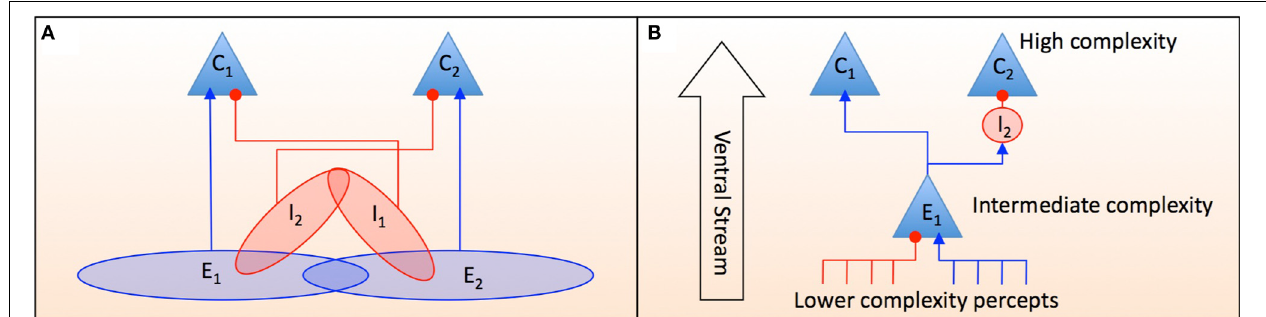
and inhibition. For example the cells in the group E 1 I 2 = E 1 ∩ I 2 excite C 1 and inhibit C 2 whereas the cells in group I 1 I 2 = I 1 ∩ I 2 inhibit both C 1 and C 2 . (B) A more detailed model showing how a neuron in assembly E 1 receives noisy inhibitory and excitatory signals from other percepts. It can then directly excite percept C 1 while indirectly inhibiting C 2 via the excitation of intermediary inhibitory neurons that terminate on C 2 . The “Ventral Stream” is the feedforward direction of the neural signaling as shown in Figure 4 .